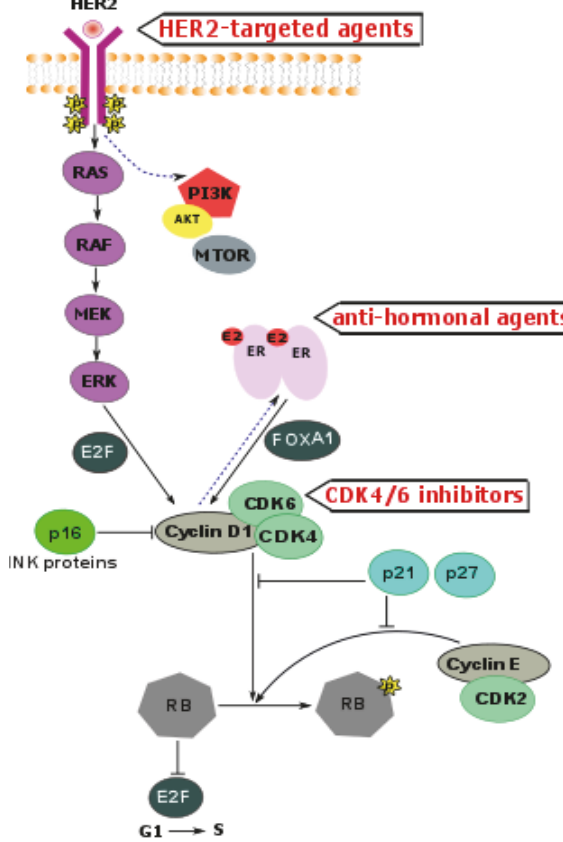
Figure 1: HR and HER2 signaling converge at cell cycle